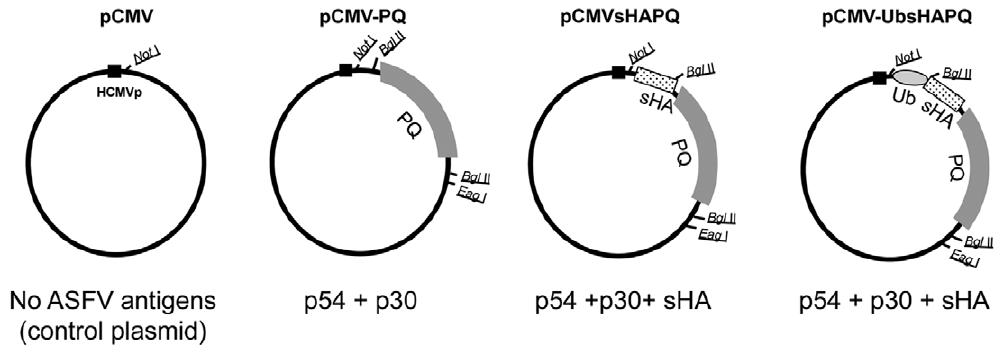
Figure 1. Schematic representation of the plasmids used for immunization and ASFV antigens by them encoded.